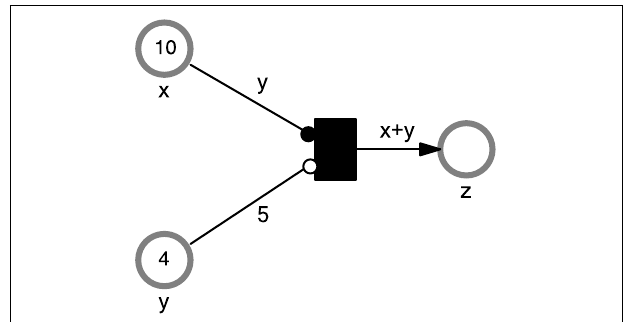
FIGURE 2 | Possible connections between GHPN elements. The (obvious) restrictions are: discrete places cannot be connected with continuous transitions using standard arcs, continuous places cannot be tested with equal arcs, and continuous transitions cannot use reset arcs.